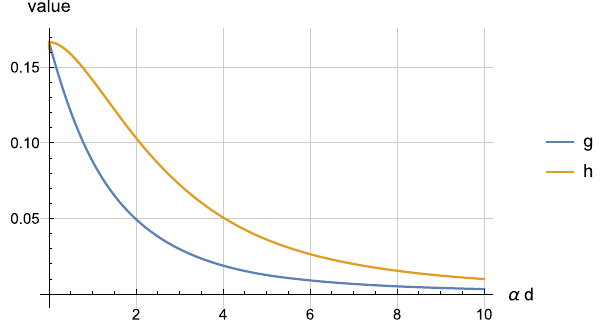
Fig. 1 The evaluation of the functions g (α d ) and h (α d ) respect to α d